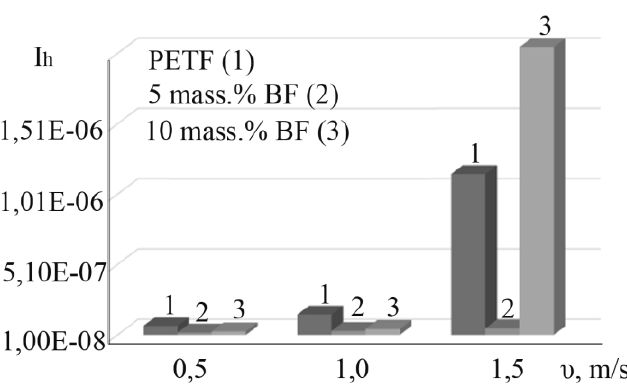
Fig. 2. Dependence of the intensity of linear wear of polyethylene terephthalate and basaltoplastics based on it on the sliding speed (specific load P = 1